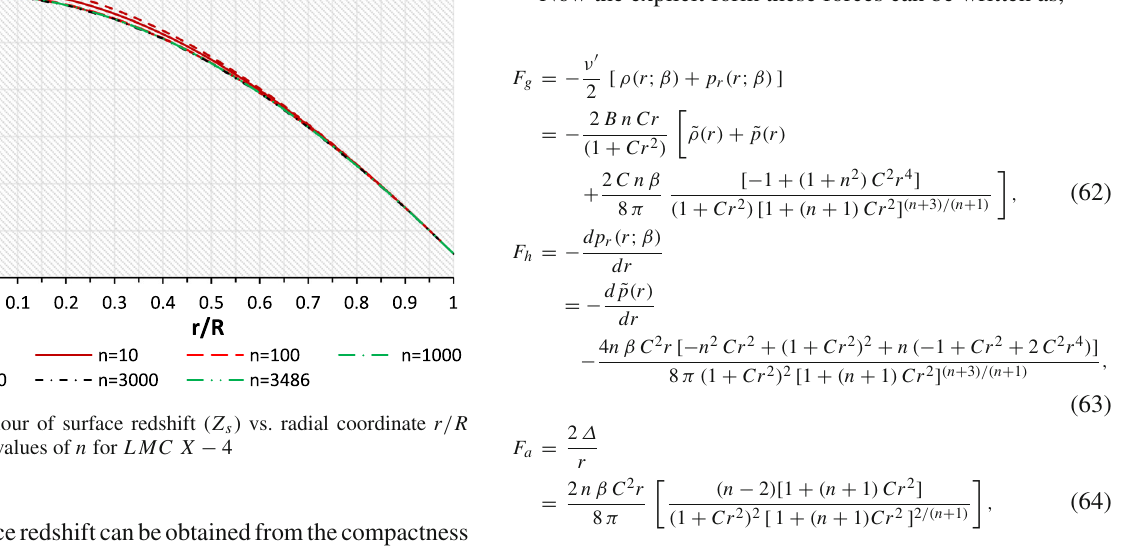
The surface redshift can be obtained from the compactness u , which is given by